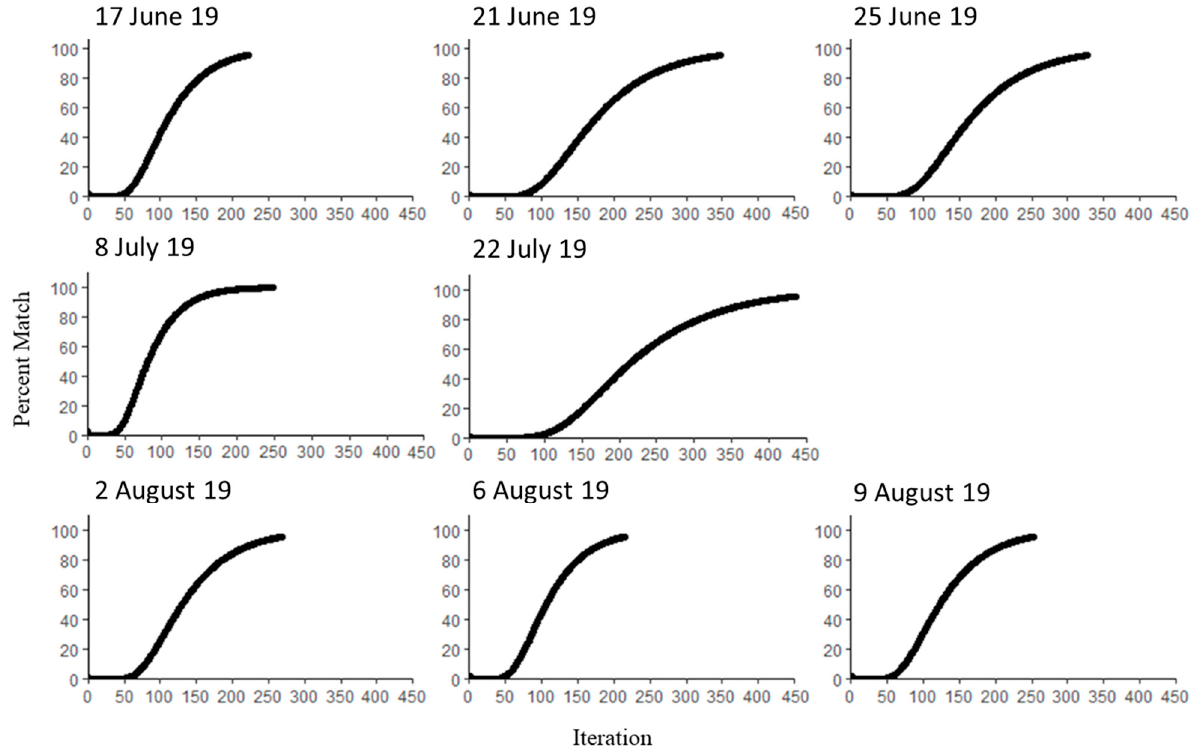
Figure 8. Percent scene match curves for Monte Carlo uncertainty analyses of HRMET-derived ET. Match determined as a pixel having an average value within 10% of the regular HRMET run.